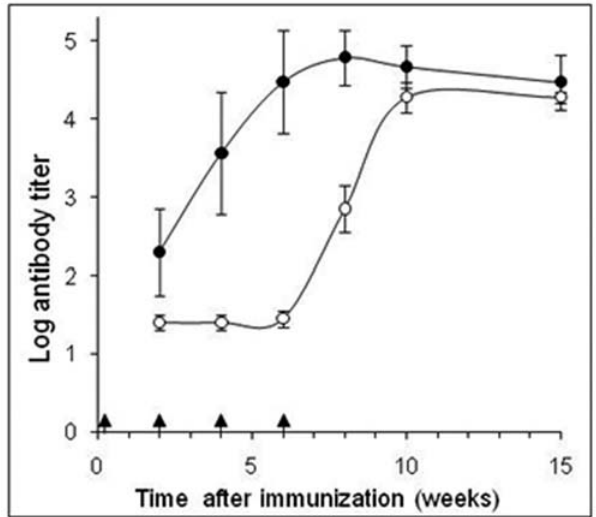
Figure 1. Kinetics of anti-PA and PA-neutralizing antibody development. Average titer values of total anti-PA ELISA antibodies (filledcircles) ofeightimmunizedmiceandLeTxneutralizingantibodytiters (empty circles) of mice 3, 4, 5 and 7, throughout the immunization process. Arrows indicate PA-immunization time points; Data points are mean 6 STD.